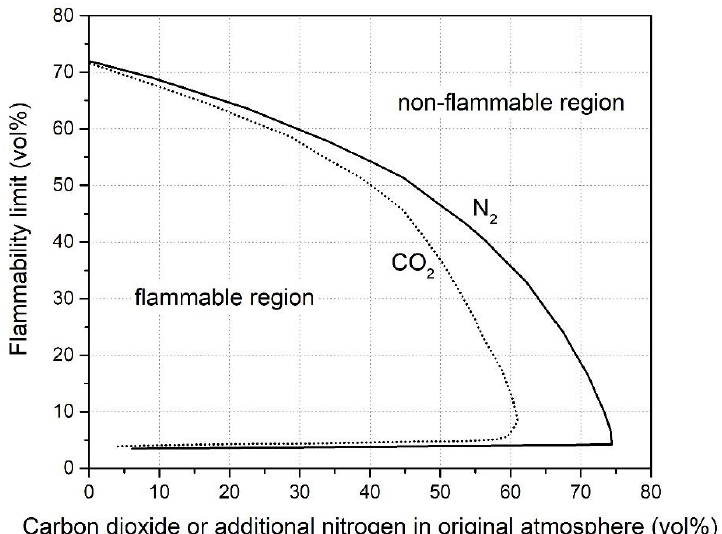
Figure 3. Measured flammability limit of hydrogen in air and nitrogen or carbon dioxide. Reproduced from Ref. [27], US Government Printing Office: 1929.